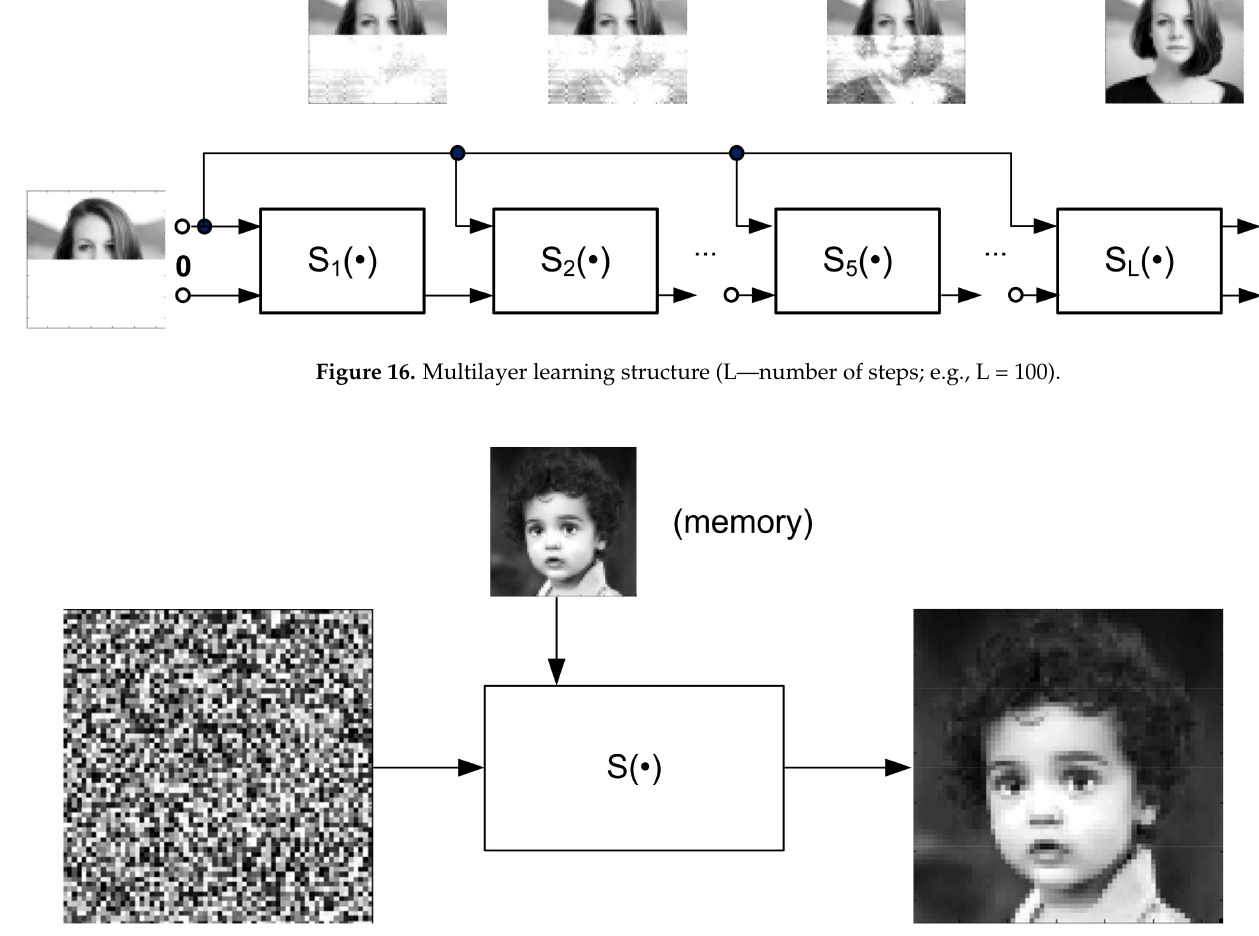
Figure 17. Illustration of global attractor